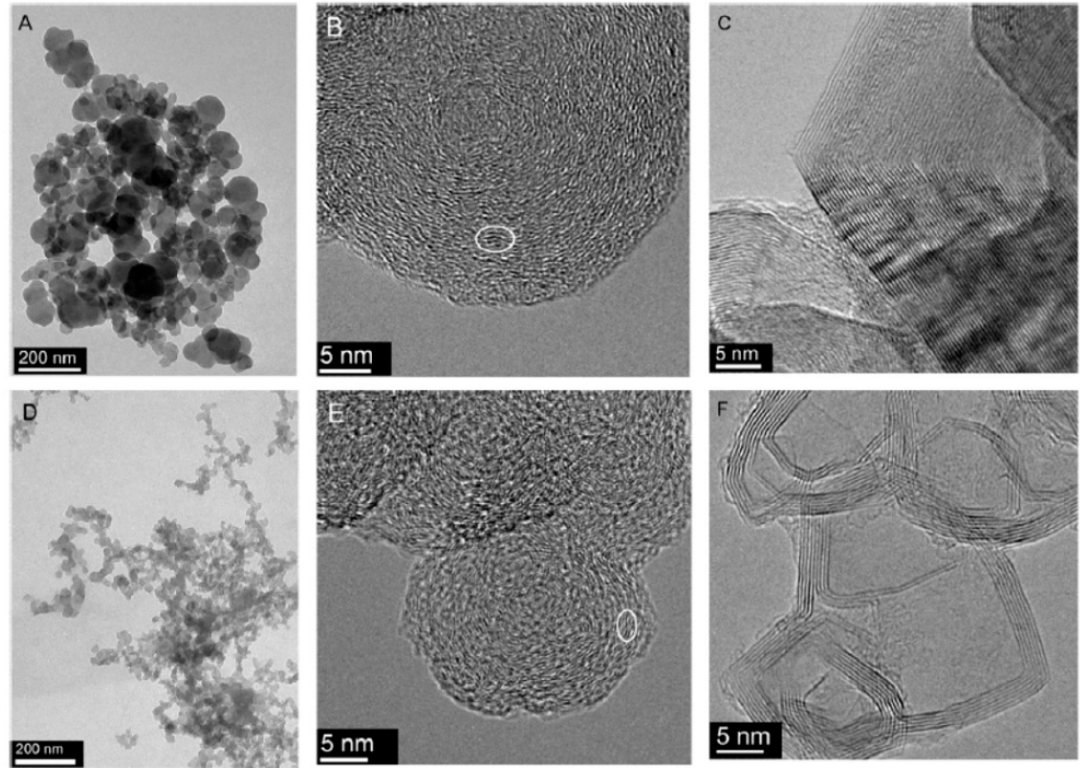
Figure 8. Comparison of the morphology and nanostructure of two carbon black grades. ( A ) Aggregate, ( B ) primary particle of unheated, and ( C ) heat-treated at 2600 °C Printex 25 carbon black; ( D – F ) FW200 carbon black, respectively. Reproduced with permission from Pawlyta et al. [46].